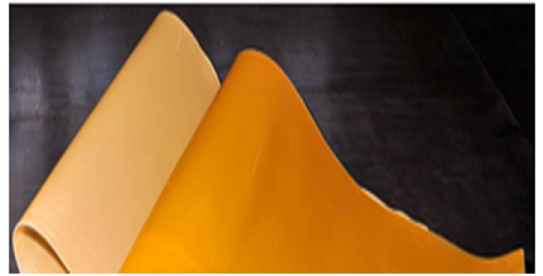
Figure 4. Cation-exchange MK-40.